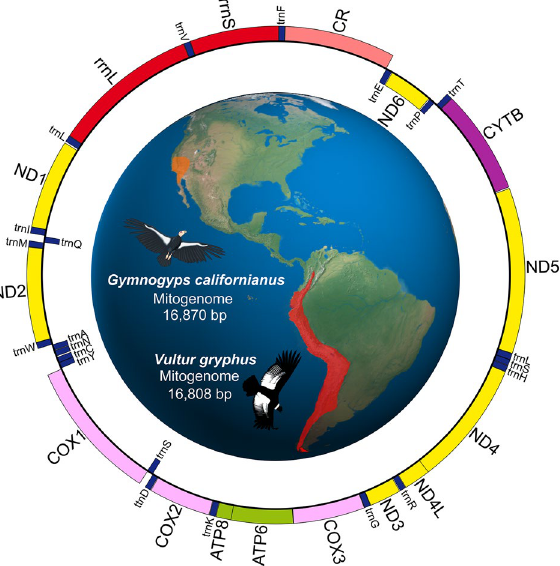
Figure 1. Organization of the mitochondrial genome of the Andean and California condor (identical schemes were recovered for both species; genes situated on the H and L strands are denoted in the outer and inner ring, respectively). The distributional range of both condor species is shown on the map. Mitogenomic assembly was schematized with OGDRAW 1.3.1 (https:// chlor obox. mpimp- golm. mpg. de/ OGDraw. html). Condor icons were taken and modified from www. freep ng. es, while the world map was taken and modified from http:// commo ns. wikim edia. org, licensed under Creative Commons Attribution 4.0 Unported license (http:// creat iveco mmons. org/ licen ses/ by/4.